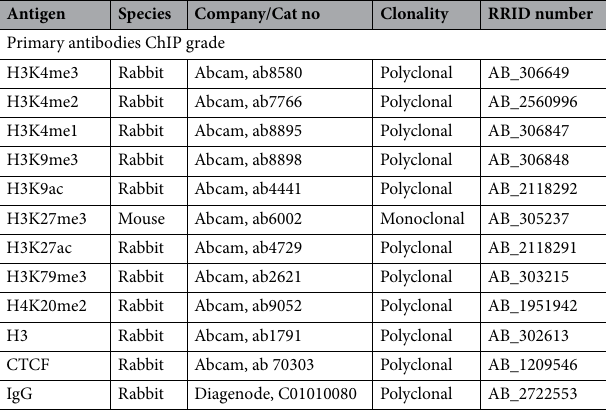
Table 1. Antibodies.